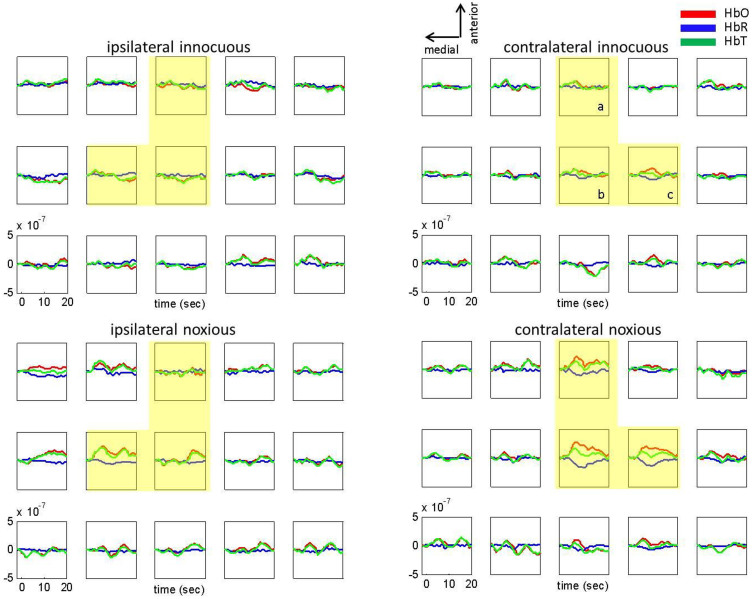
Localized hemodynamic response to left thumb innocuous and noxious electrical stimuli.Ipsilateral (left hemisphere) and contralateral (right hemisphere) hemodynamic response to left thumb innocuous (top panels) and noxious electrical stimuli (bottom panels). Group average results (n = 11) for the changes in HbO (red), HbR (blue), HbT (green). The letters a, b and c on the top right panel correspond to the same letters on Figure 7, panel B and Table 1.